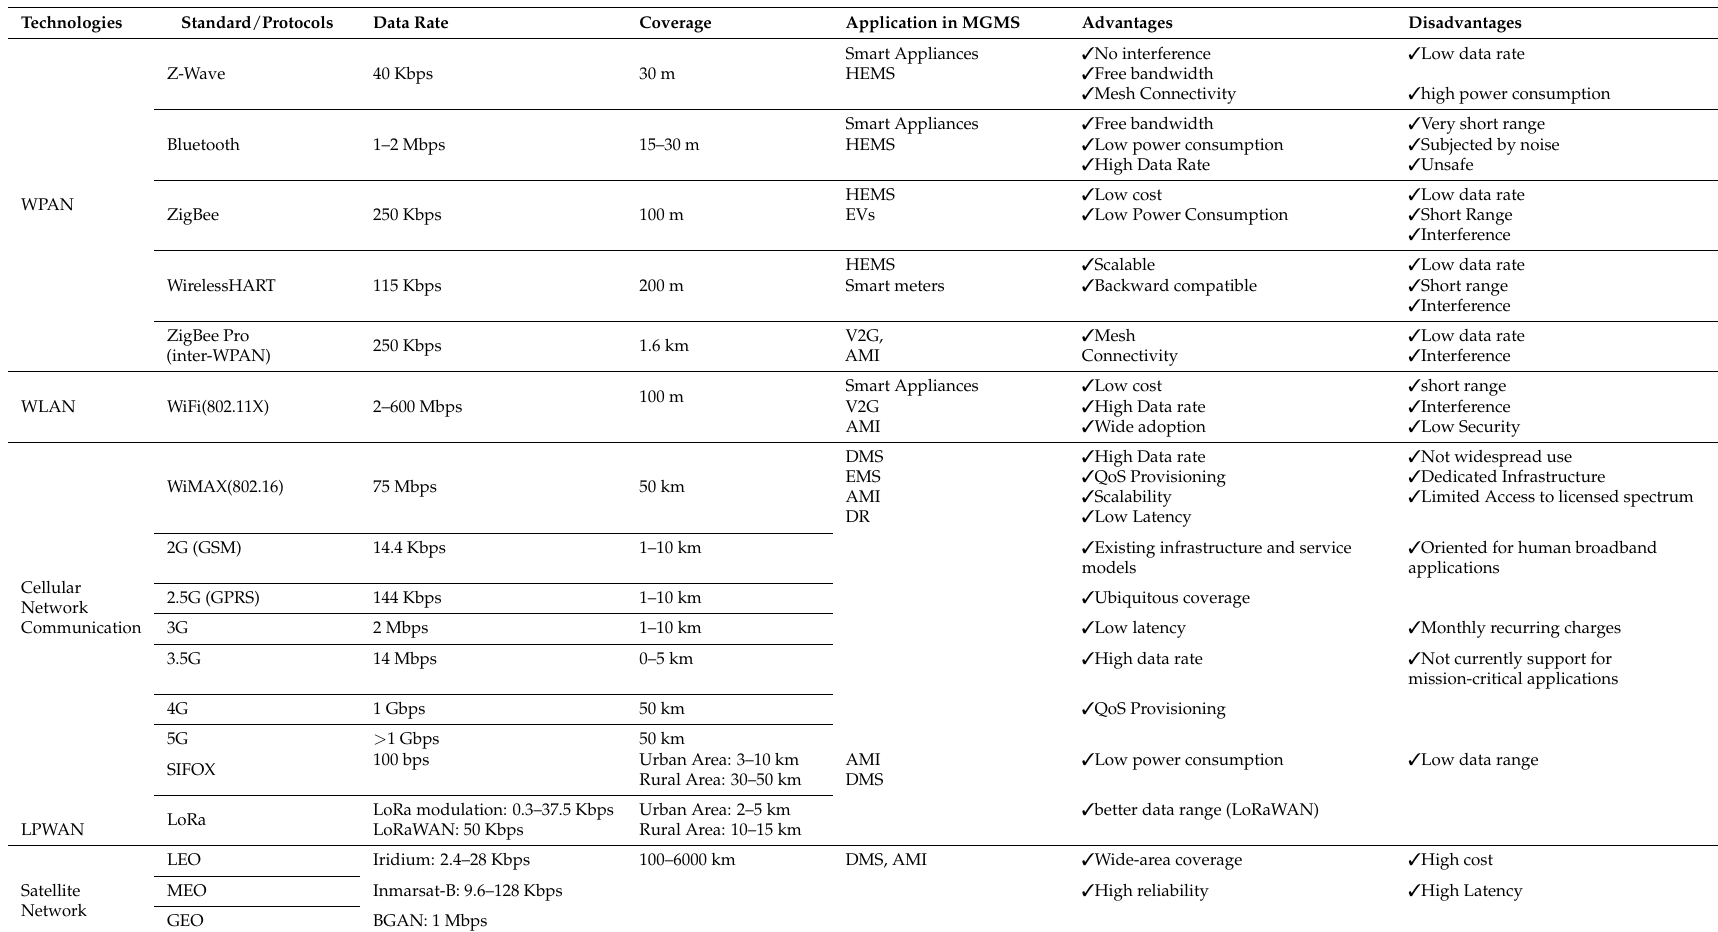
Table 5. Wireless technologies specification and application in MG communication